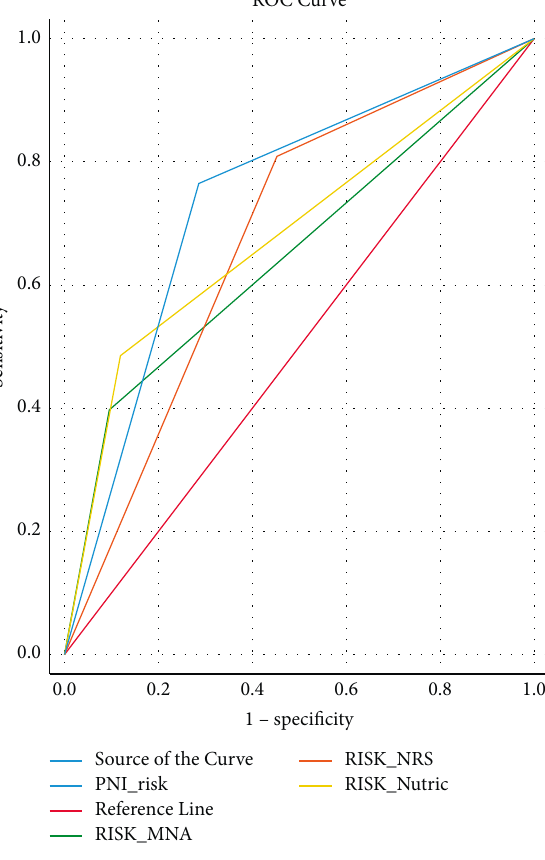
Figure 4: ROC curve for